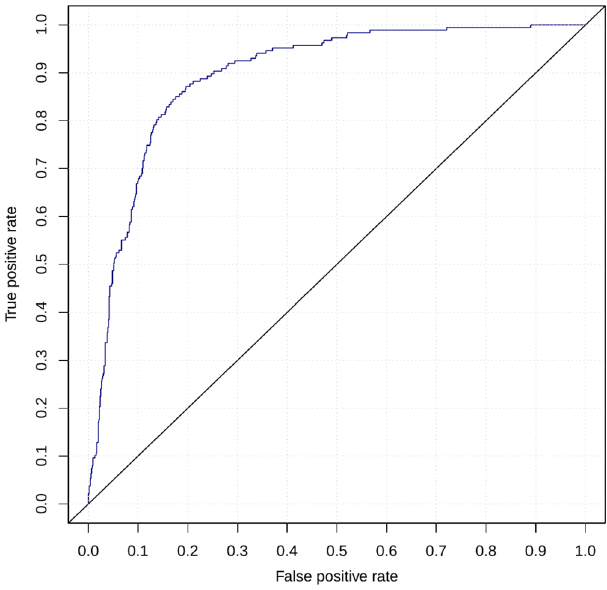
Figure 5. Validation of the 6-mRNA classifier in the COVID-19 and non-COVID-19 cohorts (pooled results of data in Figs. 3, 4, excluding healthy subjects). The total number of samples was 951. The number of cases (severe, including fatal, disease) was 187. The remaining samples (764) had non-severe disease. AUROC = 0.90 (95% CI